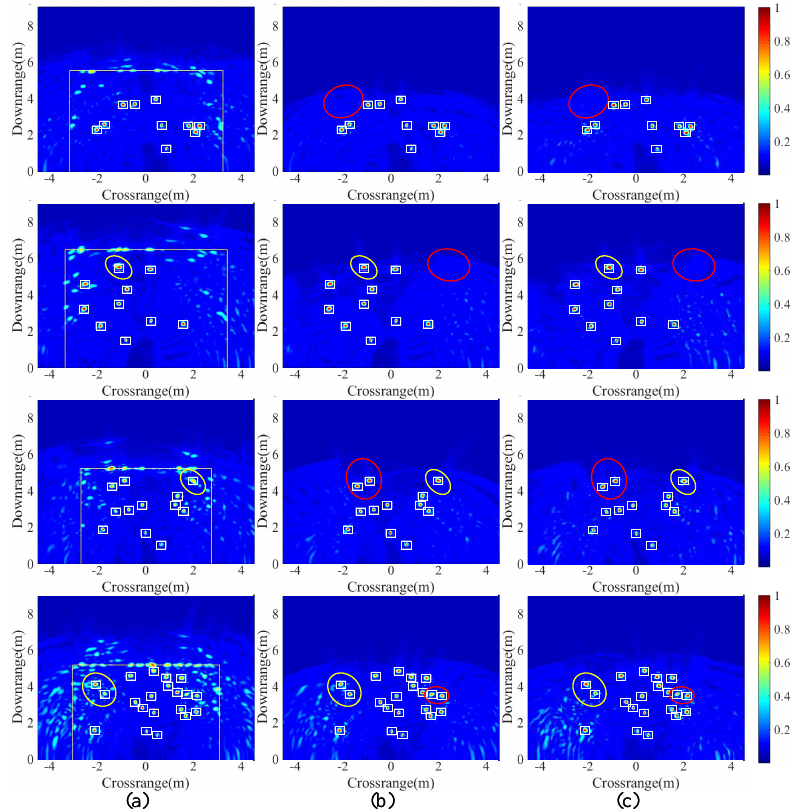
Figure 10. The results of dataset 2. ( a ) Input images. ( b ) Ground-truth images. ( c ) Output images. The red ellipses mark the differences between the output images and the ground-truth images. The yellow lines mark the walls’ locations. The white rectangles mark the targets’ positions. Moreover, the yellow ellipses mark the target images that are overlapped with multipath